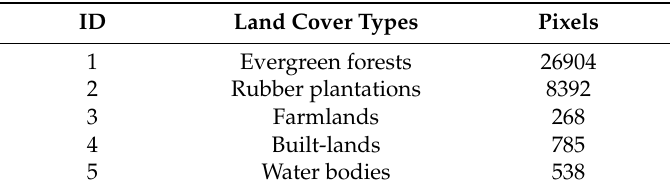
Table 1. Regions of Interests (ROIs) created from geo-referenced field photos and Google Earth high resolution images for time-series analysis, algorithm training, and result verification in the study